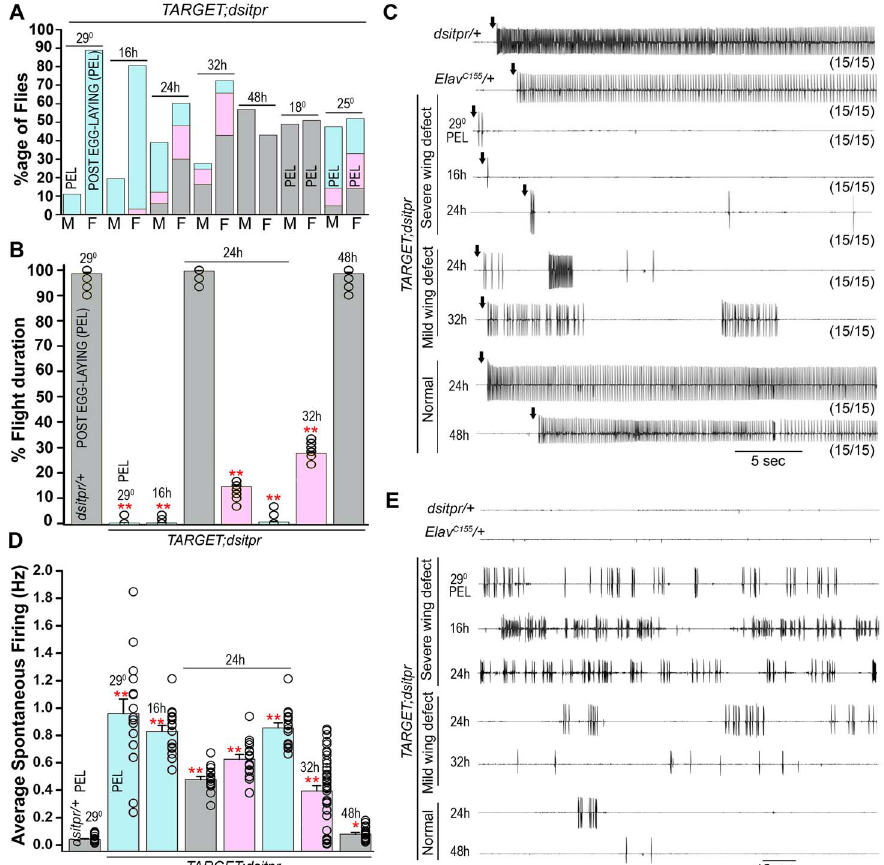
Figure 4. IP 3 R function is required from 16 to 32 hours after puparium formation to regulate flight. A ) Quantification of wing posture defects by knockdown of the IP 3 R ( dsitpr ) at specific stages during pupal development indicated above the bars using the GAL4/GAL80ts system ( TARGET ), are shown. Mixed populations of normal (grey bar), mild wing posture defect (pink bar) and severe wing posture defective (blue bar) flies were obtained when dsitpr is expressed from 16 h, 24 h or 32 h after puparium formation (APF) to adulthood, but not when expression is induced at 48 h APF and onwards. Animals were either moved from 18 u C to 29 u C, at the appropriate pupal phases to induce RNAi expression or maintained at a constant temperature post egg-laying (PEL) as indicated. Percentage of animals with varying wing posture defects is shown as a stacked histogram for males (M) and females (F). B ) Quantification of flight duration in single flight assays (mean 6 SEM) from female animals of the indicated genotypes. Open circles within each bar represent percentage flight time for each fly. Mean flight times ( 6 SEM) were obtained for three batches of 10 tethered flies of each genotype after an air-puff stimulus. All the knockdowns were compared to 29 u C dsitpr/ + control (**p , 0.01, one-way ANOVA). Color codes of the histograms are the same as in (A) above. C ) Representative traces of electrophysiological recordings from DLMs of the indicated genotypes in response to a manual air-puff stimulus (arrow). The number of flies that showed the given response upon the number of flies tested is given below each trace. Adult female flies were sorted on the basis of the severity of their wing defects as shown. Loss of rhythmic flight patterns accompanied by severe wing posture defects is observed due to pan-neuronal depletion of IP 3 R during early pupal development (16 h APF). Knockdown at later time points shows reduced flight duration in flies with mild wing posture defect and normal flight in animals with normal wings. D ) Quantification of the frequency of spontaneous firing as recorded from DLMs of the indicated genotypes. As with flight deficits and air-puff induced electrical firing patterns, spontaneous firing frequencies are higher in animals with wing posture defects (color coded as in A) and the time of transfer to 29 u C. (**p , 0.01, *p , 0.05, one-way ANOVA, N=15). Firing frequencies were calculated by counting the number of spikes over 2 min. Individual data points are represented by open circles. E ) Representative traces for (D) showing increased spontaneous firing in animals with severe wing posture defect due to early knockdown of the IP 3 R.